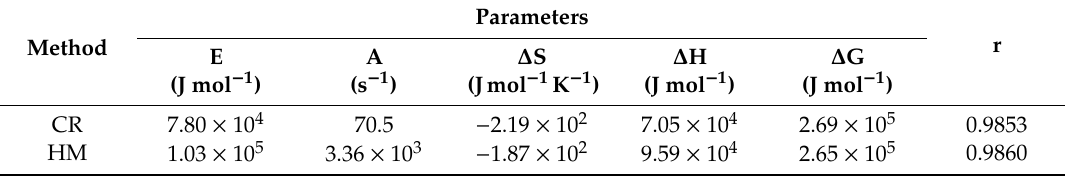
Table 2. Kinetic and thermodynamic parameters of the second thermal decomposition step of the oxidovanadium(IV)–AMP complex.